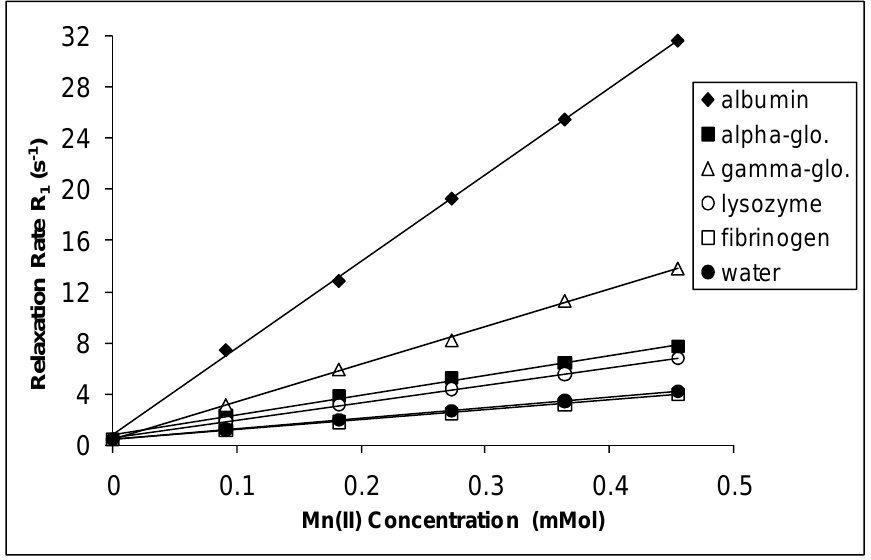
Figure 1. The Spin-lattice Relaxation rates (R